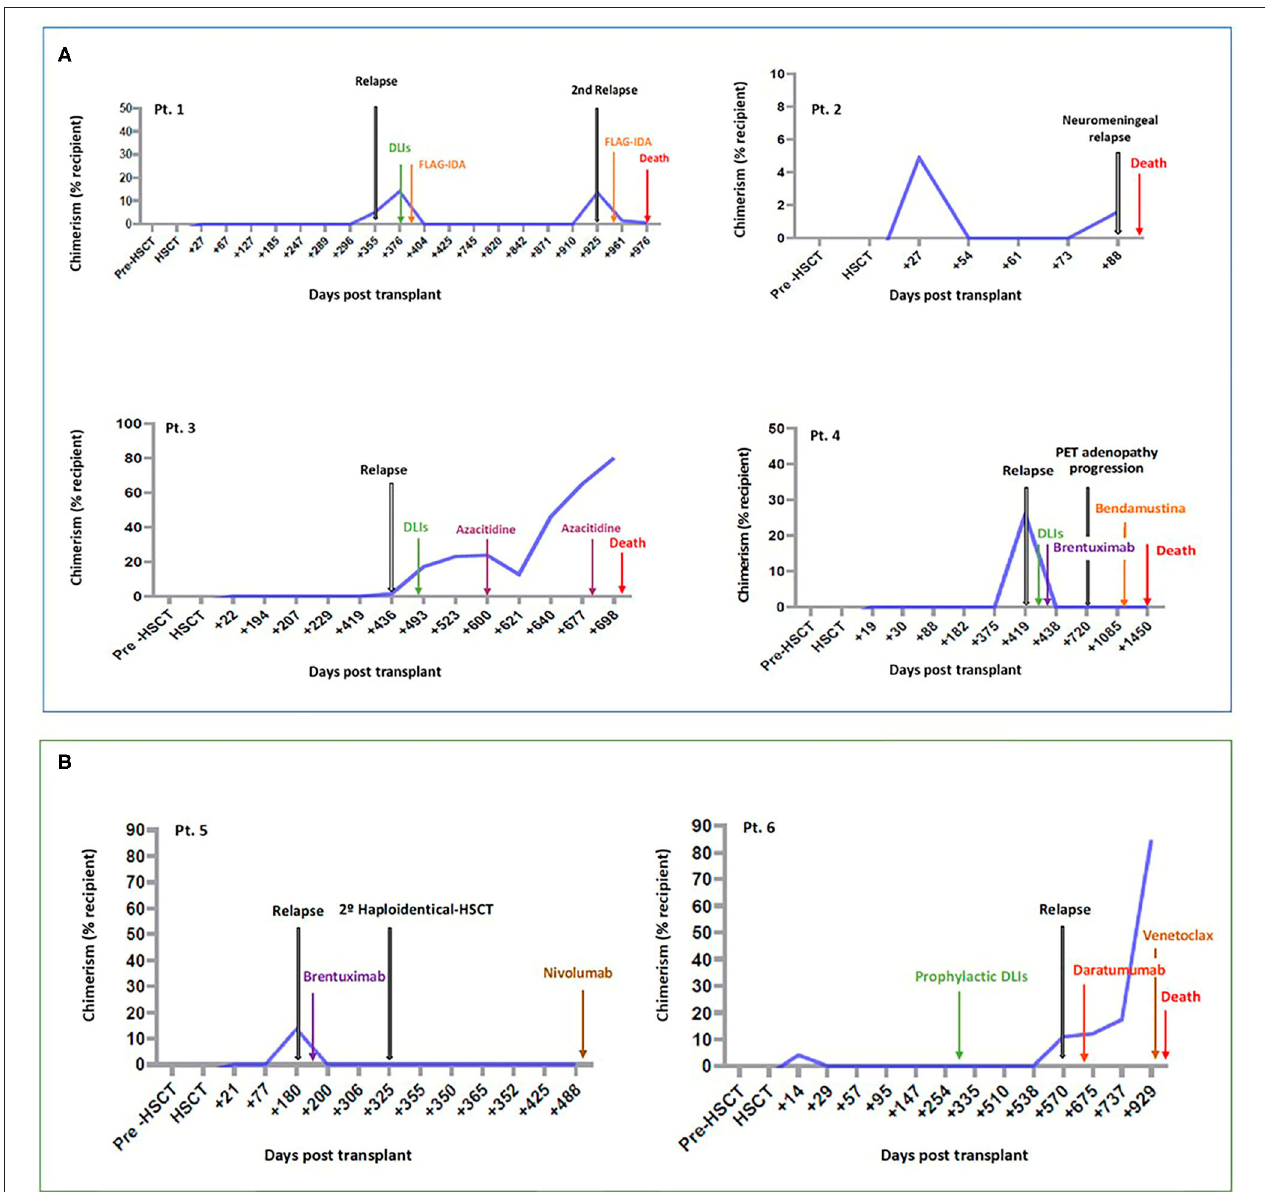
FIGURE 1 | Patients with HLA-loss at relapse. Follow-up of patients in which HLA-loss was identified retrospectively (A) and patients identified prospectively, in which HLA-loss could be used to drive therapeutic decisions (B) . Pt, Patient; HSCT, hematopoietic stem cell transplantation; DLIs, Donor lymphocyte infusions.